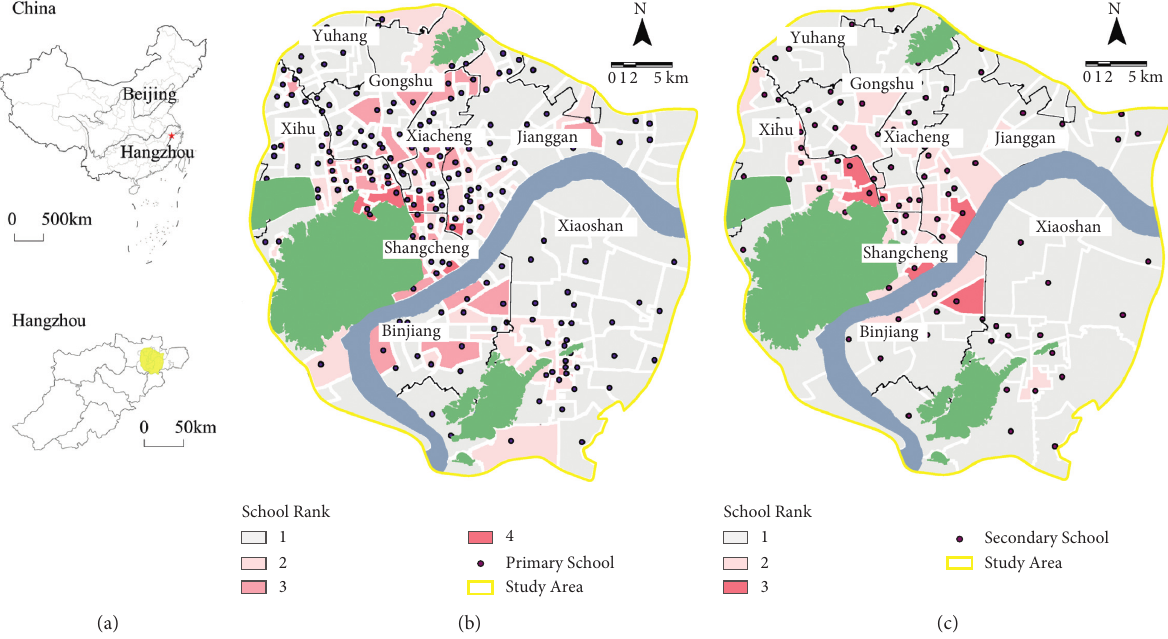
Figure 1: Study area and subject. (a) Location of the study area. (b) Distribution of primary schools and school districts. (c) Distribution of secondary schools and school